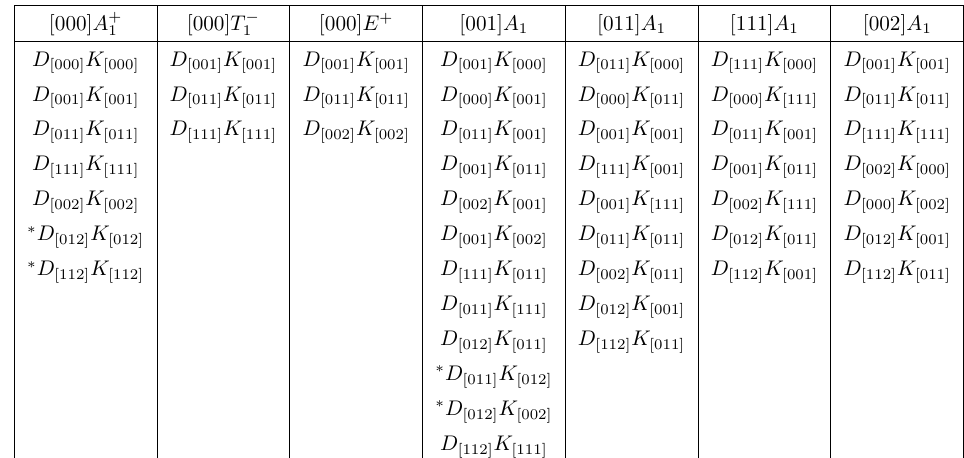
Table 7 . As table 6 but for DK I = 0 on the m π = 391 MeV ensembles. The ¯ qq operators include some combination of Dirac γ -matrices and up to two spatial covariant derivatives. The irreps in the bottom row were not used on the 16 3 volume.